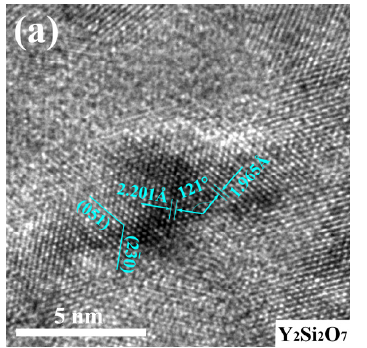
Figure 10. ( a ) HRTEM image of the Y 2 SiO 5 nanoparticle in 1280-S3 ODS steels; ( b ) FFT diagram